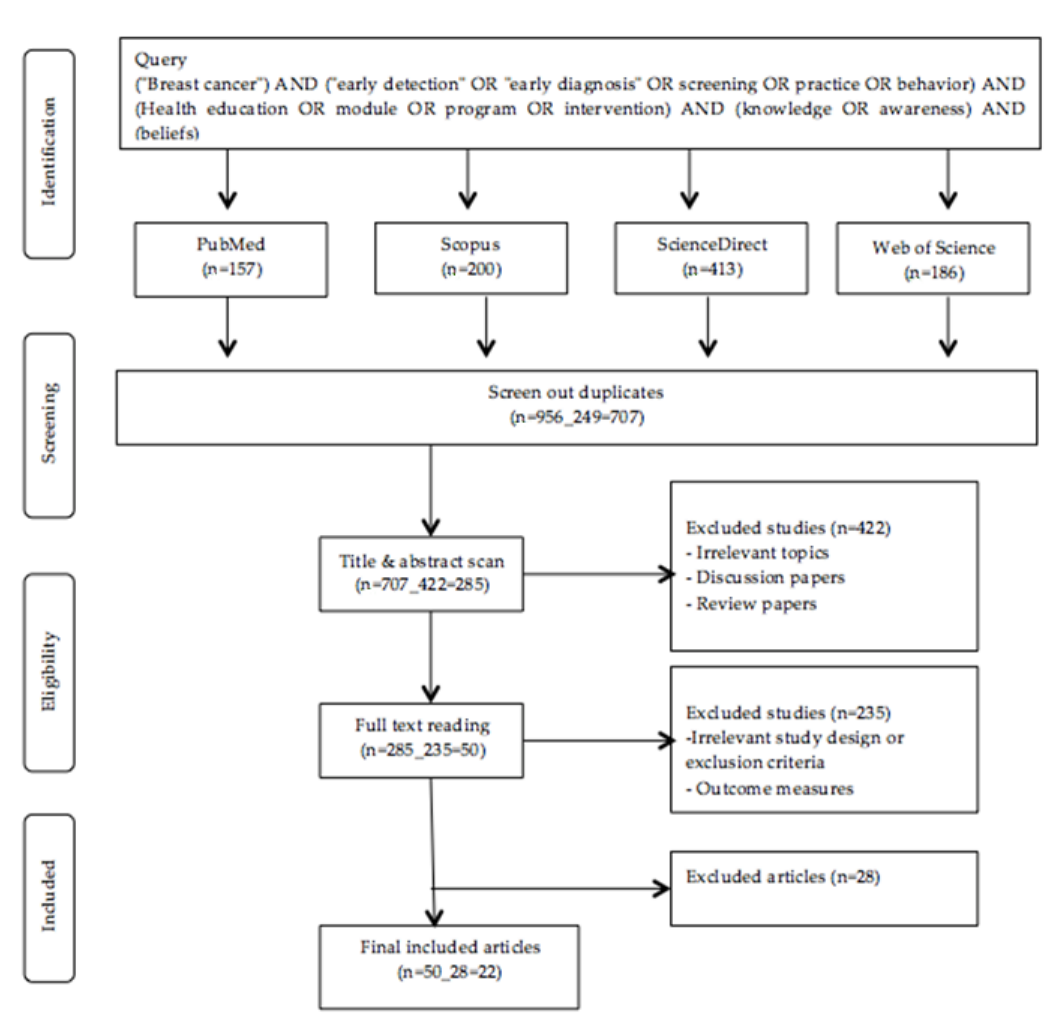
Figure 1. Flow chart of study selection.